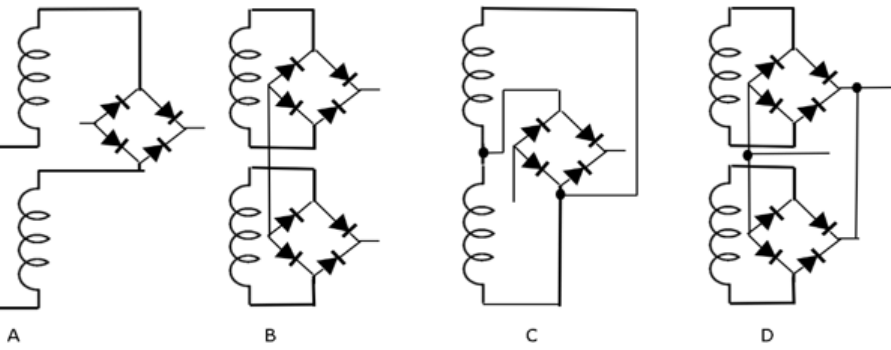
Figure 6. ( A ) Coils in series followed by rectification. ( B ) Coils in series after rectification. ( C ) Coils in parallel followed by rectification. ( D ) Coils in parallel after rectification